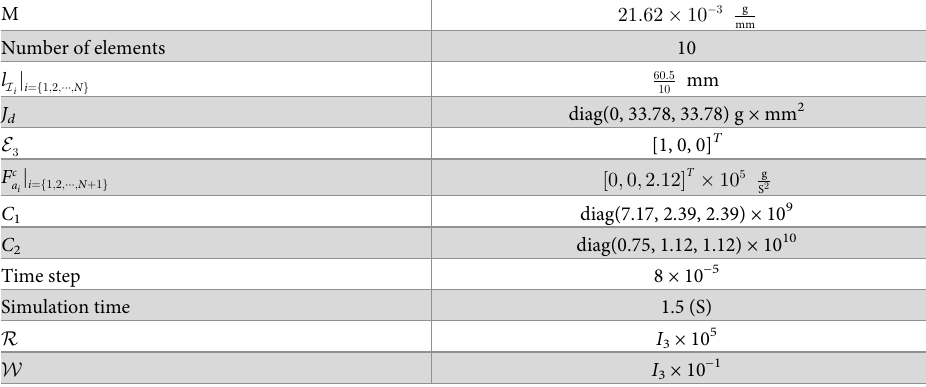
Table 5. Simulation parameters in Eqs (10)–(16)and (21) for in-plane experiment of PDMS rod (without